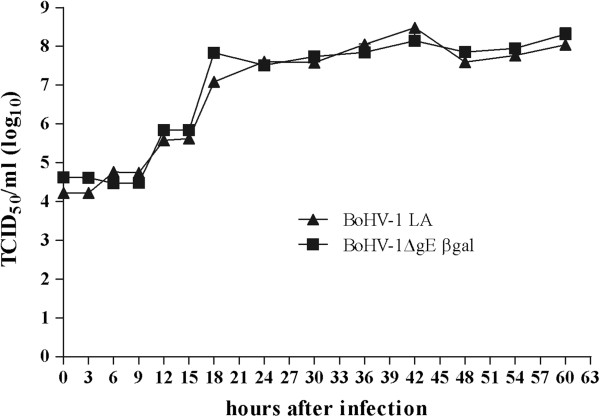
Growth kinetics of the BoHV-1ΔgEβgal virus. MDBK cells were infected at a MOI of 0.1 with either BoHV-1ΔgEβgal or BoHV-1 LA virus strains. Viral replication was checked every 3 hours during a period of 60 hours pi. Virus titrations were performed in duplicate for each time point on MDBK cells. Titers are expressed as TCID50/ml. Each data point represents the mean of the titers obtained.